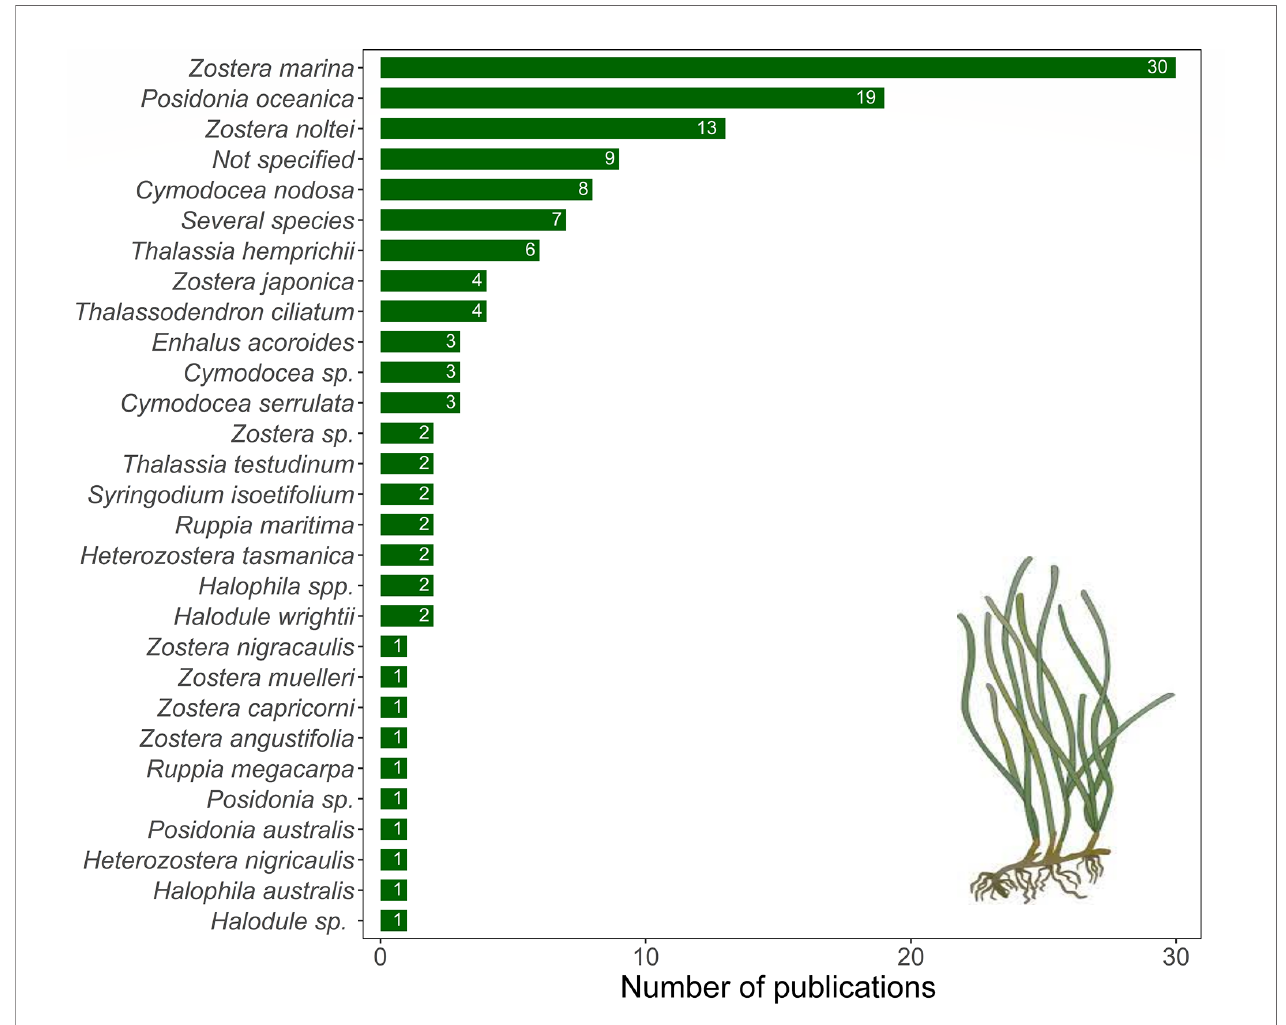
FIGURE 4 | Number of publications assessing each seagrass